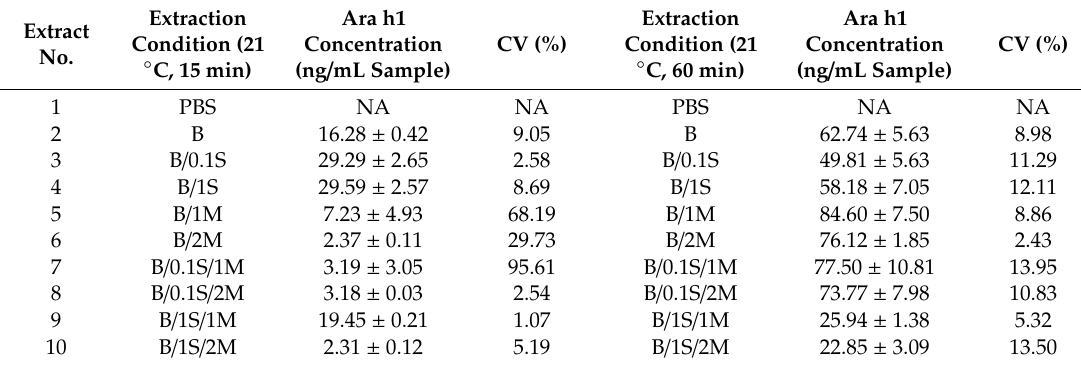
Table 2. E ff ect of temperature (21 ◦ C) and time (15 min, 60 min) on Ara h 1 extraction from commercial peanut butter food sample according to the extraction condition